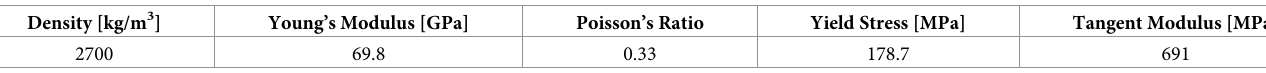
Table 2. The material model for aluminum 6061 used for the